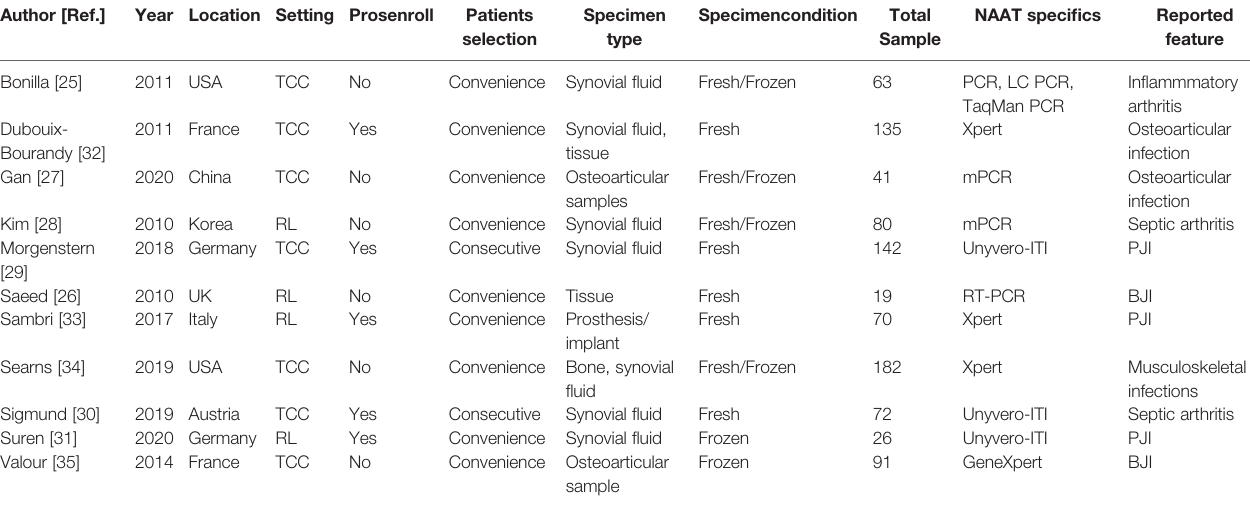
TABLE 1 | Baseline features of included studies.